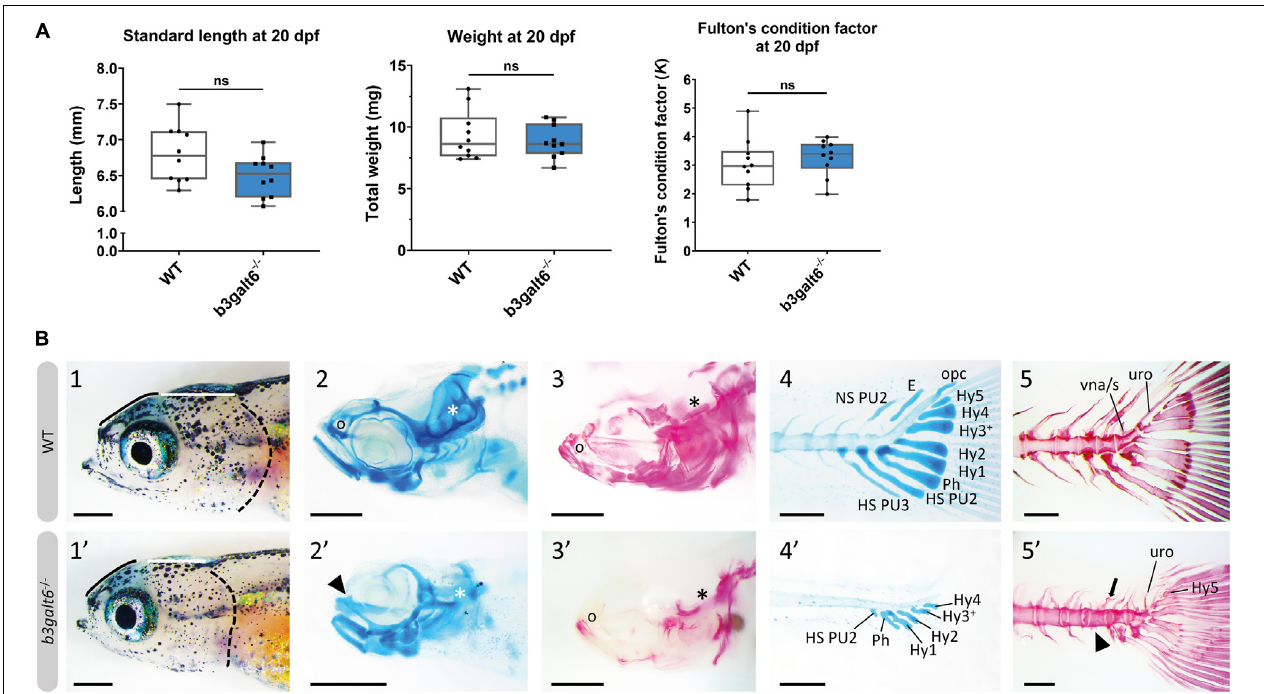
FIGURE 3 | Developmental delay and morphological abnormalities in 20 dpf b3galt6 − / − zebrafish. (A) Weight, standard length and Fulton’s condition factor of WT and b3galt6 − / − zebrafish larvae at 20 dpf ( n = 10). (B) External phenotype of the head of juvenile WT and b3galt6 − / − sibling zebrafish. All images are oriented anterior to the left, posterior to the right, dorsal to the top and ventral to the bottom. (1-1’) b3galt6 − / − zebrafish display a rounder frontal region (black line), shorter parietal/occipital region (white horizontal line) and a malformed posterior edge of the opercular apparatus (dotted black line), compared to WT control. (2-2’) Representative images of cartilage AB staining of the head. The olfactory region (indicated by “o” in the WT and arrowhead in the b3galt6 − / − picture) and the otic region (indicated by white asterisk) show delayed development of cartilage elements in b3galt6 − / − zebrafish as compared to WT. (3-3’) Representative images of AR mineral staining of the head. The olfactory region (indicated by “o”) and the otic region (indicated by asterisk) show severely delayed mineralization in b3galt6 − / − zebrafish larvae as compared to WT. (4-4’) Representative images of AB staining of the caudal fin. The modified associated elements show developmental delay in b3galt6 − / − zebrafish as compared to WT. E, epural; HS PU2, haemal spine of preural 2; HS PU3, haemal spine of preural 3; Hy1–5, hypural 1–5; NS PU2, neural spine preural 2; opc, opistural cartilage; Ph, parhypural (5-5’) Representative images of AR mineral staining of the caudal fin. Caudal vertebrae and their associated elements show no delay in ossification. Malformation or absence of caudal fin associated elements (block arrow indicates a neural arch; arrowhead indicates a missing haemal arch), and malformation of uroneural (uro) and vestigial neural arches and spines (vna/s) are observed in b3galt6 − / − zebrafish; hypurals have a bent appearance. Scale bars: images of the head 500 µ m, images of the caudal fin 200 µ m.